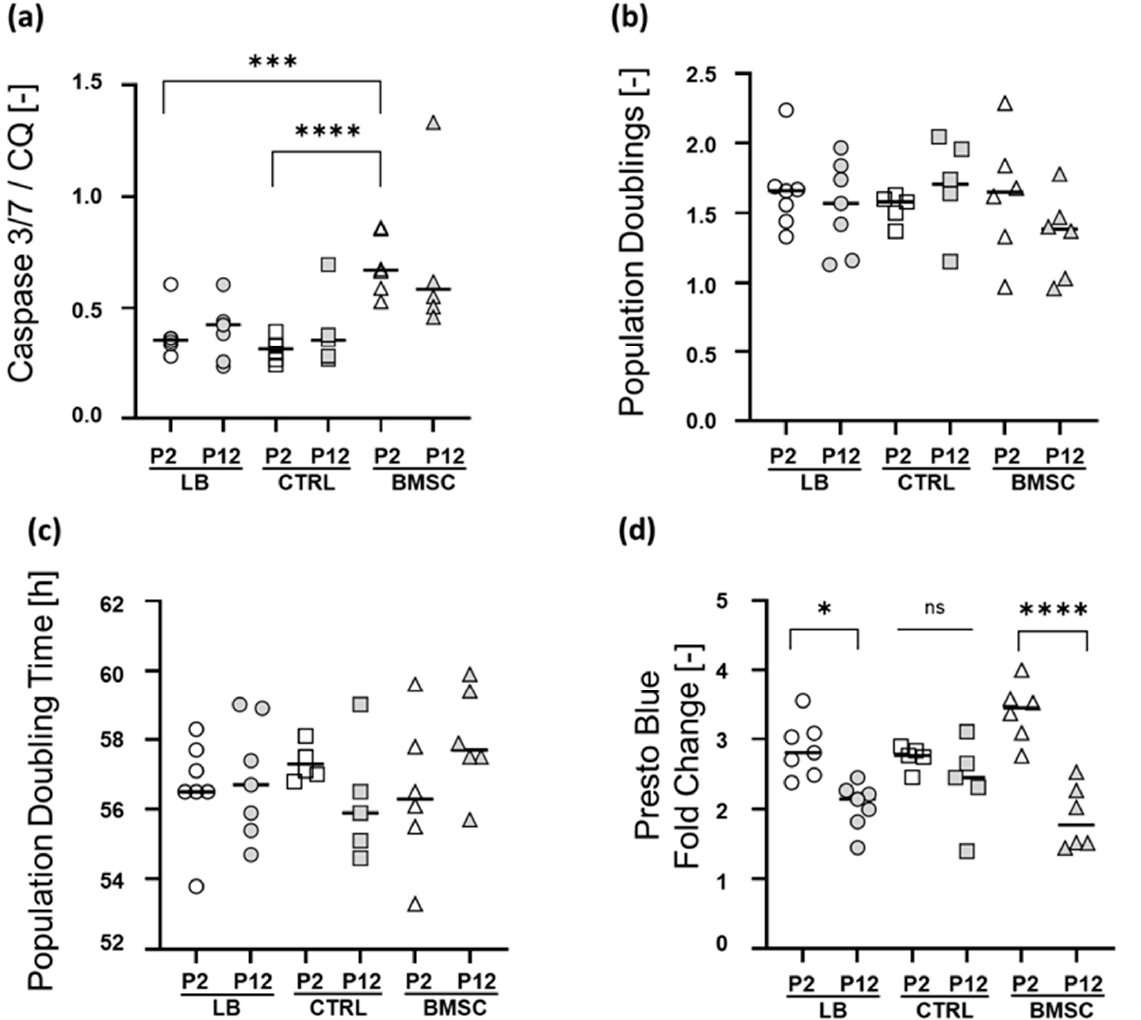
Figure 3. Apoptosis rate, short-term proliferation characteristic and metabolic activity. ( a ) Levels of active Caspase 3/7 as a surrogate marker of apoptosis were determined in early (P2) and late passage (P12) cultures of all three groups. Shown are the caspase 3/7 activities normalized to the cell number. ( b ) Population doublings (PD) [-] and ( c ) Population doubling time [h] of chondrocytes and BMSCs were determined over a nine-day culture period using CyQUANT™ cell proliferation assay. ( d ) The metabolic activity as an indicator for cell viability was determined using PrestoBlue™ viability assay over a nine-day culture period. Graph indicates the fold change in metabolic activity between day 0 and day 9. (LB n = 7, CTRL n = 5, BMSC n = 6, repeated measures, median line depicted, one-way ANOVA with multiple comparisons (Tukey), p -values of multiple comparisons as depicted; ns = not significant, * = p ≤ 0.05, *** = p ≤ 0.001, **** = p ≤ 0.0001).